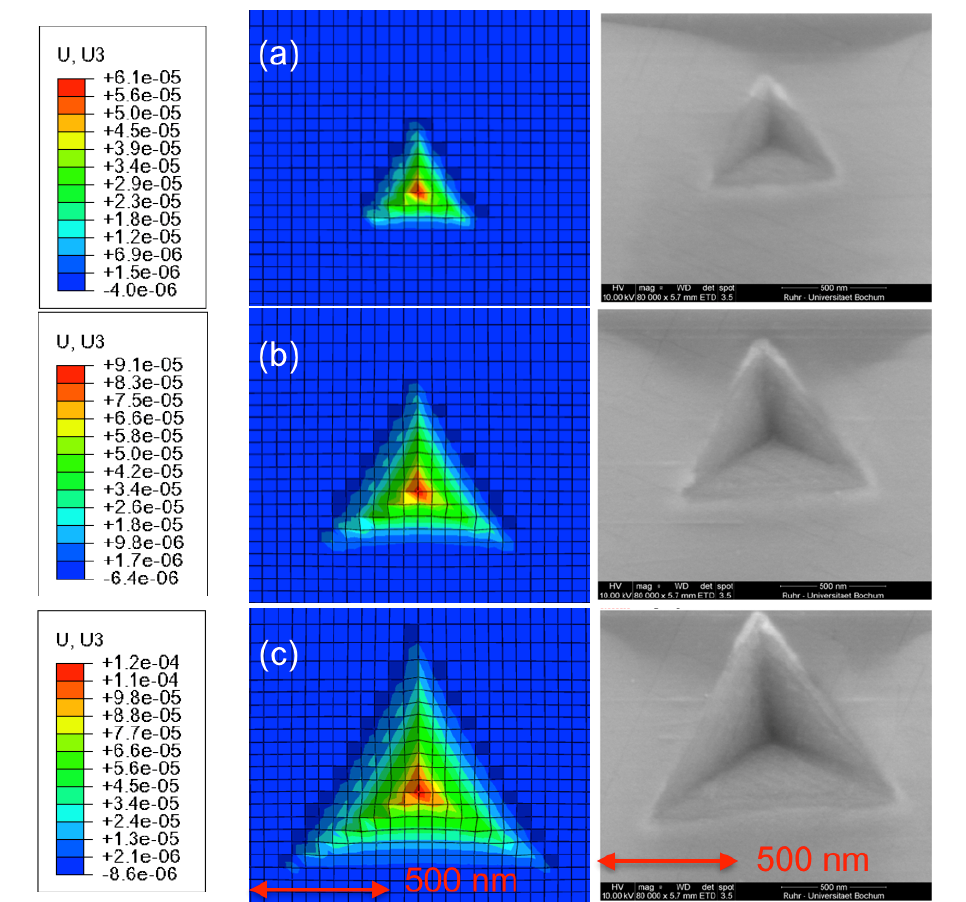
Figure 5. Residual imprint of the nanoindentation of ( a ) 105 nm, ( b ) 157 nm, and ( c ) 208 nm depth as obtained from the FE simulations ( left ), where the displacement in normal direction to the surface is shown (in mm). SEM image of indented surface for the same indentation depths ( right